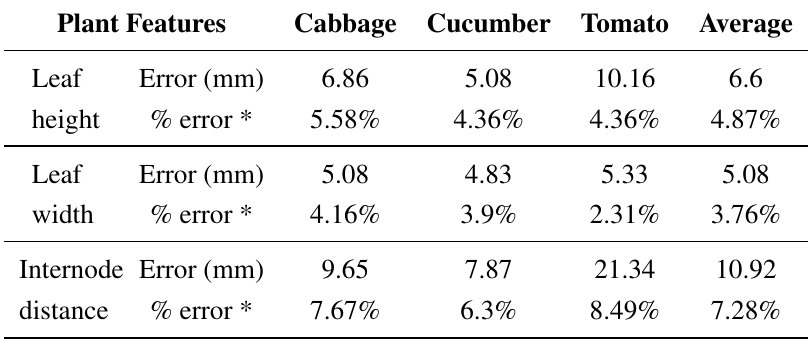
Table 3. Average accuracy in plant phenotype estimation from 3D reconstruction.